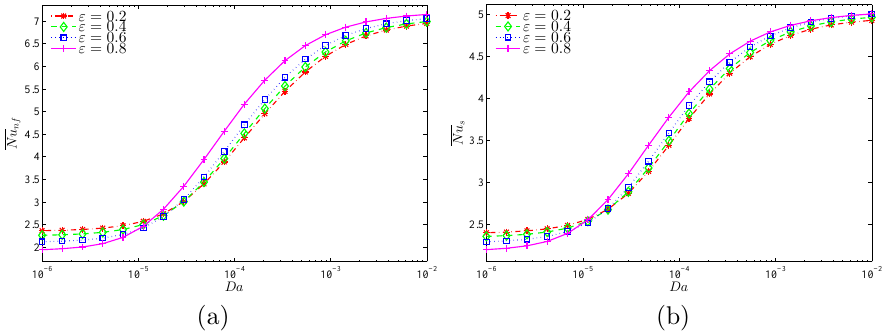
Figure 17. Variations of ( a ) the average Nusselt number of the nanofluid phase and ( b ) the average Nusselt number of the solid phase with Da for different ε values at φ = 0.02, γ = 10, and A = 0.1. Figure 18 characterizes the variation of Nu nf and Nu s with the modified thermal conductivity ( γ ) for various values of ε . Nu nf increases with the increment of γ for all values of ε . Meanwhile, there is a limit in the increase of Nu s with γ after a certain value of ε . This explains that the role of the nanofluid in transferring heat through the porous medium becomes greater than for the solid matrix due to its high thermal conductivity.